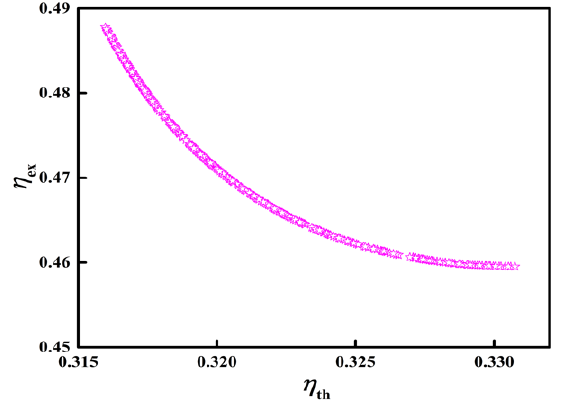
Figure 11. Pareto optimal solution for η th and η ex . Table 6. The partial Pareto optimal solution for η th and η ex .